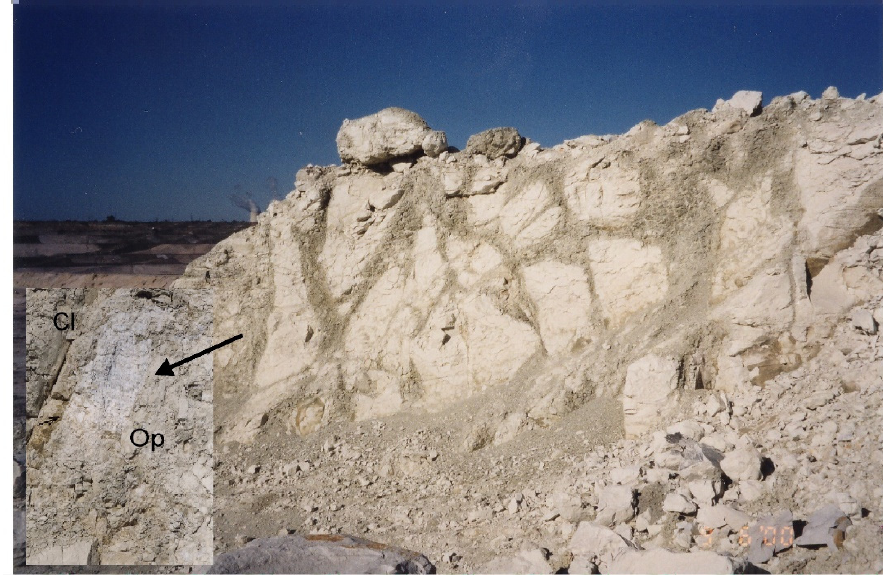
Figure 4. Precipitation of opal on the slope of the opencast mine in the Be ł chatów lignite deposit. Explanation of symbols: Op–opal, Cl–claystone.